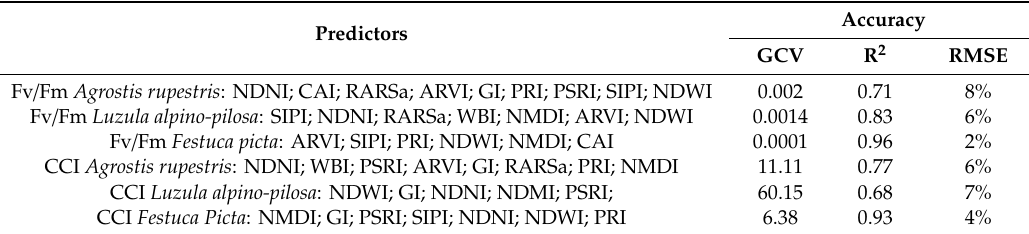
Table 4. Equation of indices Fv / Fm (n = 72,000) and CCI (n = 48,000) of dominant species, Generalized Cross Validation (GCV) error, R 2 and RMSE values. Formula of the indicator in Appendix